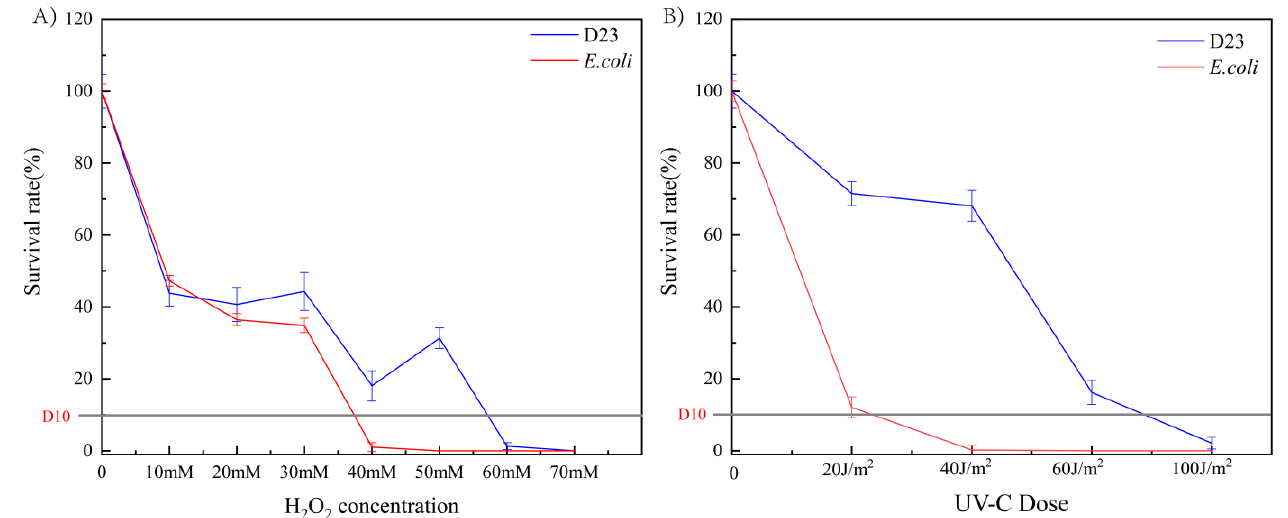
Figure 2. Survival rates of strain D23 under UV-C and hydrogen peroxide stress. ( A ) Survival rate of strain D23 and E. coli after exposure to 0 – 70 mM hydrogen peroxide stress; ( B ) survival rate of strain D23 and E. coli after exposure to UV-C radiation in a dose range of 0 – 100 J/m 2 . D10 values: dose required to kill 90% of cells.